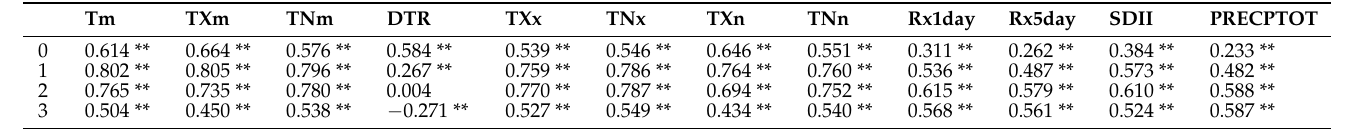
Table 6. Correlation coefficients between the regional mean NDVI and the extreme temperature (precipitation) indices for different time lags during